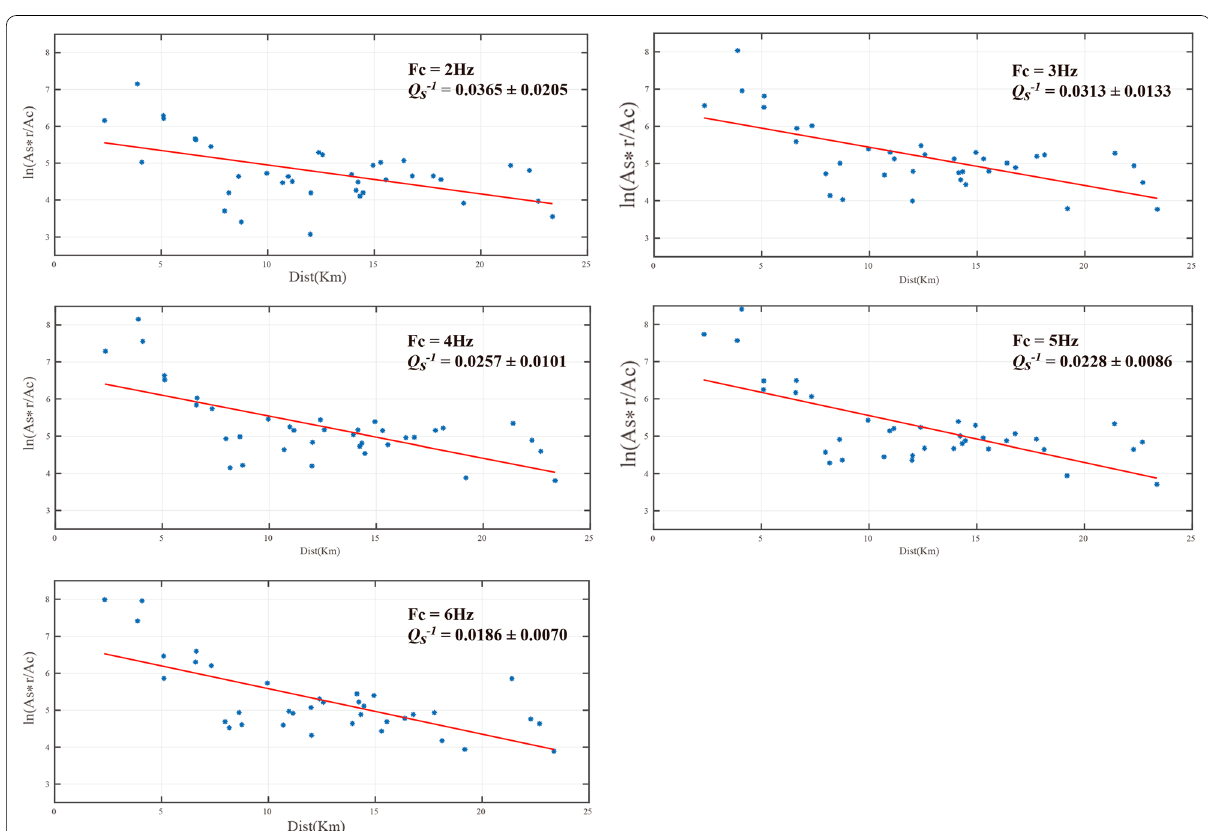
Fig. 9 Coda-normalized RMS amplitude decay of S waves with hypocentral distance. The solid red lines indicate the least-squares fitting curves. The numbers written in each frame are the Q − 1 s value and its corresponding center